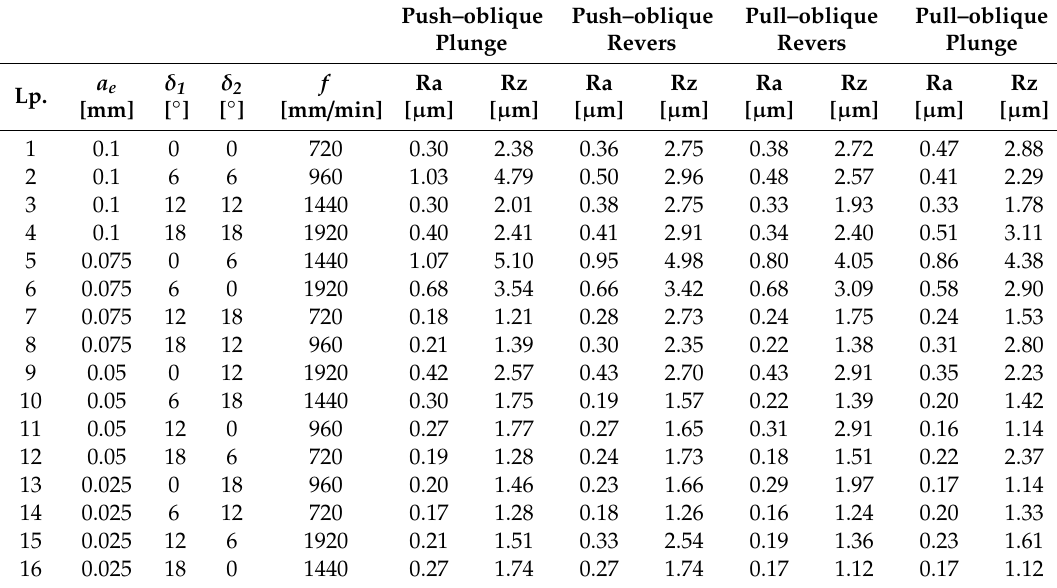
Table A2. Average values of the parameters Ra and